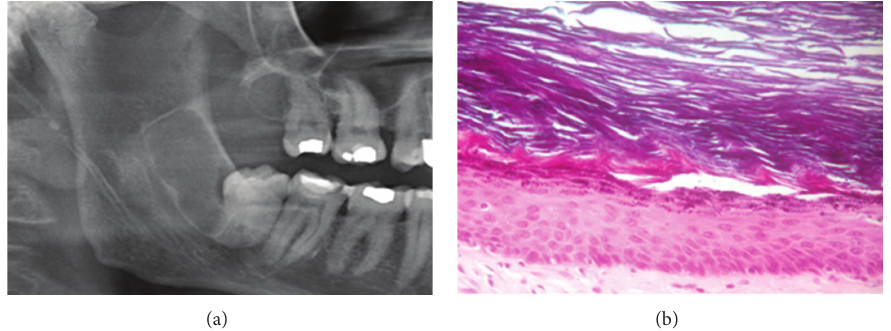
Figure 3: (a) Initial orthopantomography. (b) Fibrous connective tissue with a stratified epithelium with hyperorthokeratosis